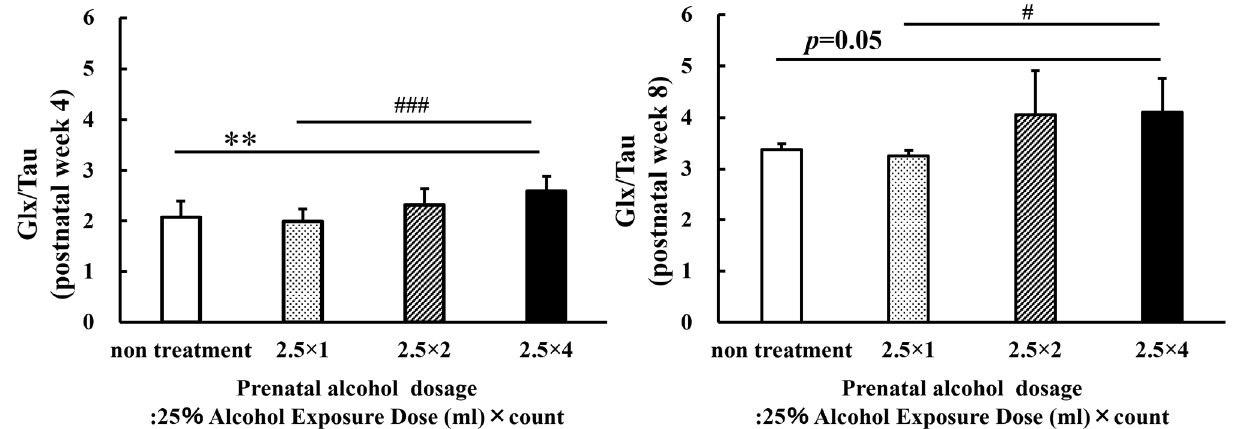
Figure 8. Graphs of the sum (Glx) of glutamine (Glu) and glutamic acid (Gln) were compared with taurine (Glx/Tau). The increase in the Glx/Tau level increased with the alcohol dosage. Between- group comparisons were analyzed by one-way ANOVA with Tukey’s multiple comparison tests using Prism 9. The four-dose group (2.5 × 4) at 4 weeks of age showed a more signi fi cant increase in the Glx/Tau level compared with those of the non-treatment group ( p < 0.01) and the one-dose FASD group (2.5 × 1; p < 0.001). The four-dose group (2.5 × 4) at 8 weeks of age showed a more signi fi cant increase in the Glx/Tau level than the one-dose FASD group did (2.5 × 1; p < 0.05). The results showed no signi fi cant di ff erence between the two-dose group (2.5 × 2) and the four-dose group (2.5 × 4). As compared with the non-treatment: ** p < 0.01. As compared with the one-dose FASD group (2.5 × 1): # p < 0.05; ### p < 0.001.